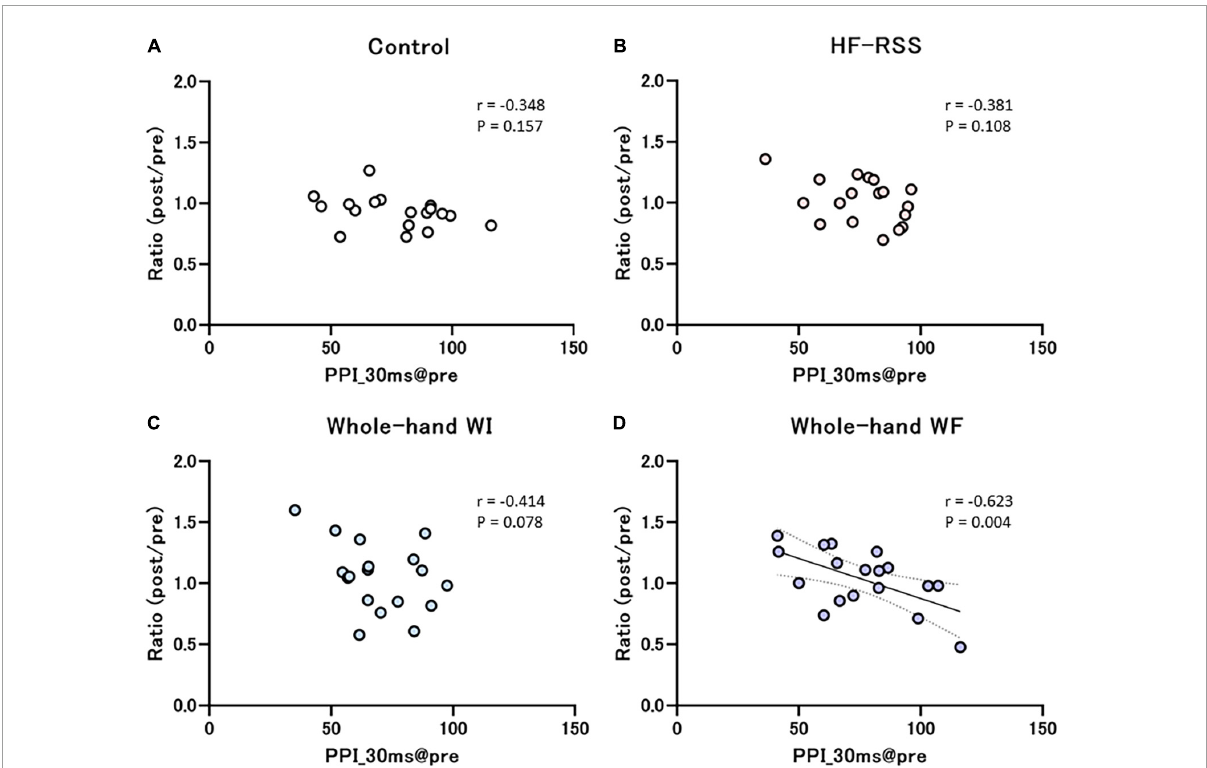
FIGURE8 Correlation between PPI_30 ms at pre-intervention and the ratio of before to after each intervention: (A) Control, (B) HF-RSS, (C) Whole-hand WI, and (D) Whole-hand WF. There was a significant negative correlation only in whole-hand water immersion, but not in other interventions. HF-RSS, high-frequency repetitive somatosensory